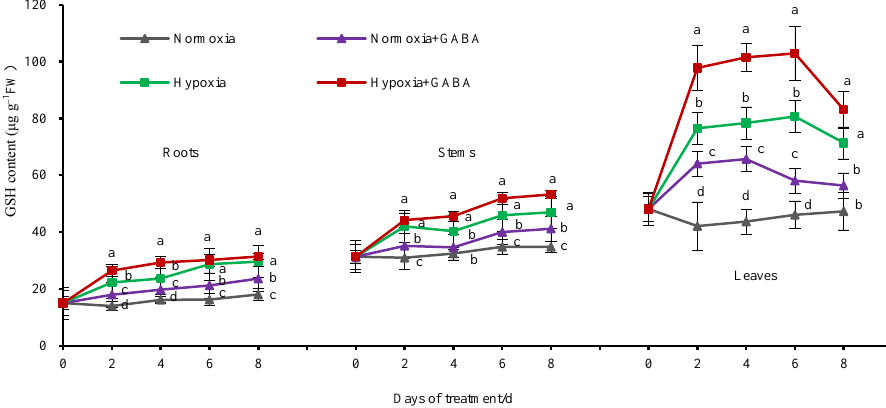
Figure 6. Effects of exogenous GABA on GSH contents in roots, stems, and leaves of melon seedlings under root hypoxic stress for 0, 2, 4, 6, and 8 d. Different letters a – d indicate significant difference ( p < 0.05).